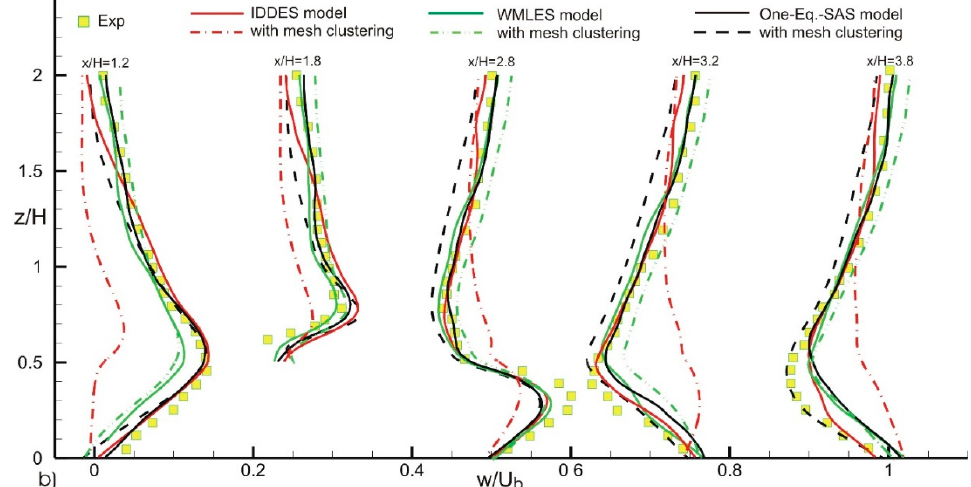
Figure 5. Effect of ( a ) mesh density, and ( b ) mesh clustering on the average sapnwise velocity in the XZ plane cutting through the center of the cube at y/H = 0.5. Each successive x/H profile starting from the one at x/H = 1.2 is offset by one unit from the previous profile.